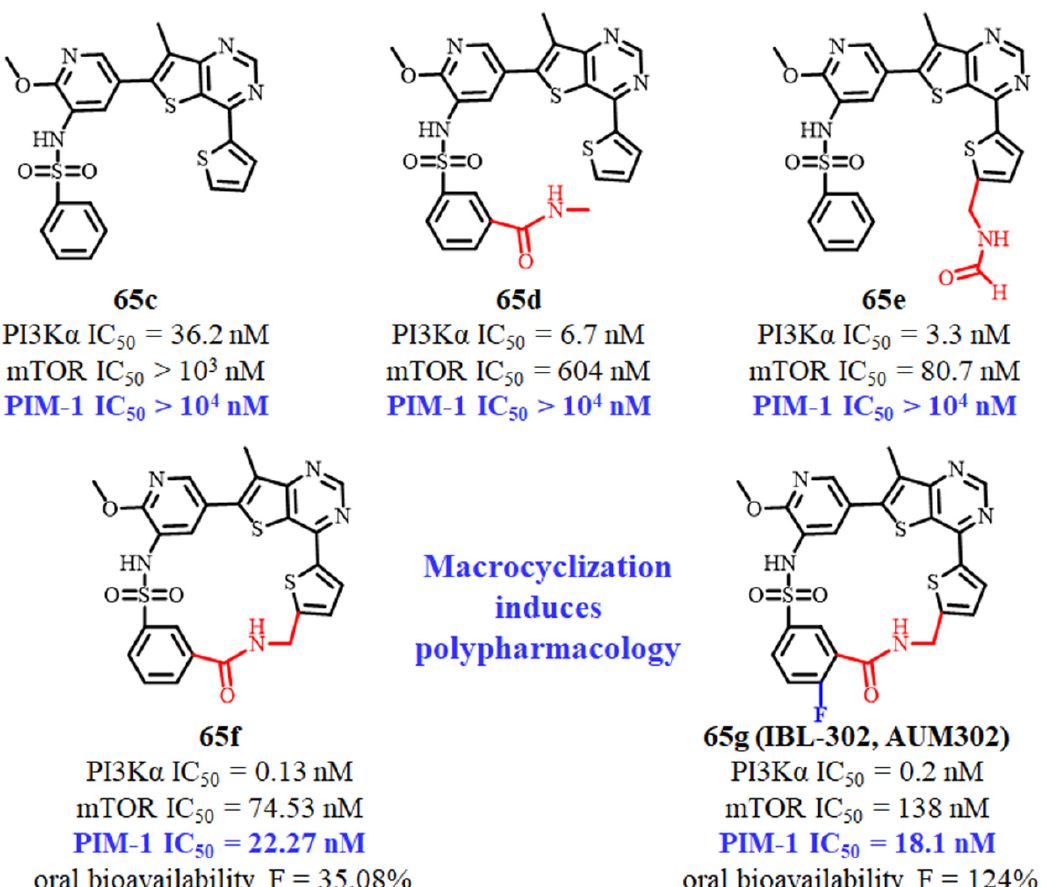
Figure 23. Open precursors ( 65c – 65e ) and biological activity in comparison with 65f and 65g